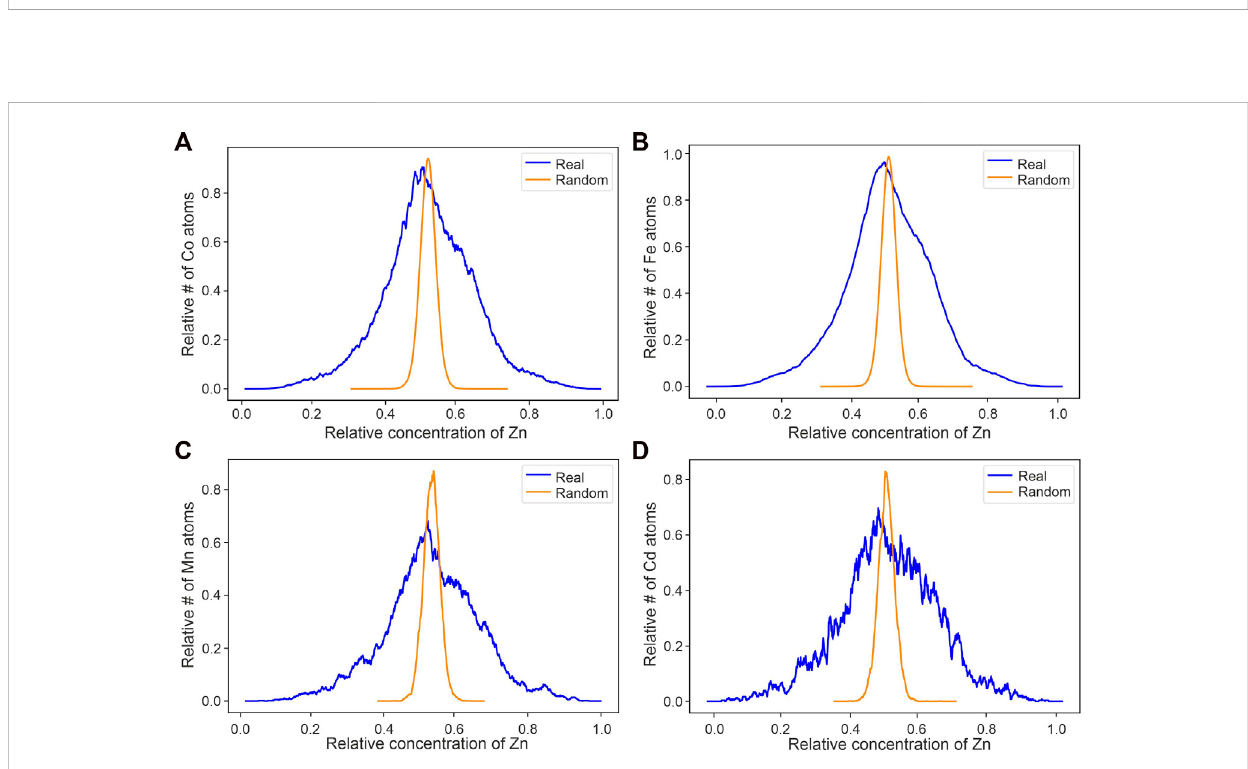
FIGURE 6 Localconcentration ofZnsurroundingCo, Fe,Mn,andCdions [ (A – D) respectively],themostabundant minor andtraceelements. Y -axisshows the relative number of Co, Fe, Mn, and Cd ions that are surrounded by a relative concentration of